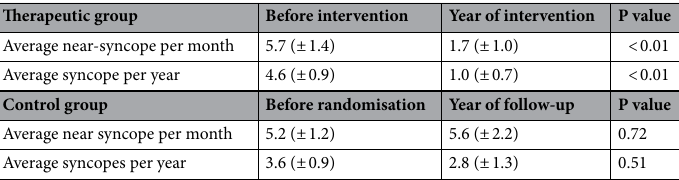
Table 2. Comparison between the average number of syncope and near-syncope prior to the randomisation versus during the year post-randomisation. Values are means ±